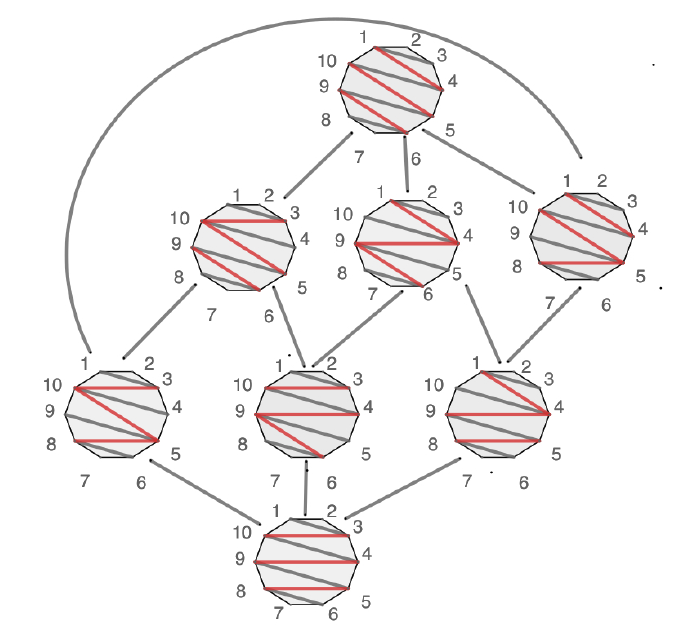
Figure 17 . The Polytope is a cube as can been seen above each quadrangulation is a vertex and the lines joining them represent edges, each closed loop represents a face. The set of common diagonals which complete the triangulation are shown in